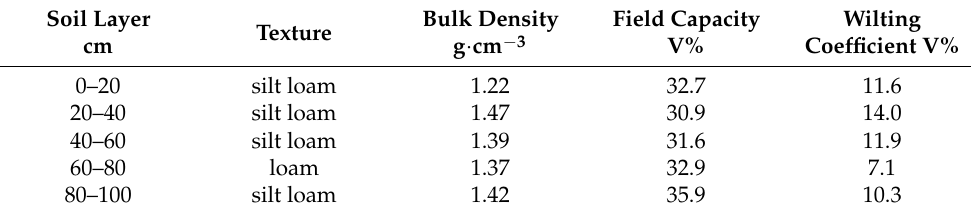
Table 1. Foundation soil samples and moisture constants.